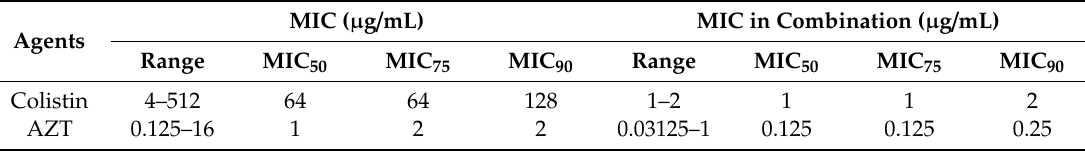
Figure 1. Distribution of the examined resistance mechanisms among the 40 isolates. ( a ) non-KPC producers; #, number of simultaneous resistance mechanisms (number of isolates) ( b ) KPC producers, with one isolate lacking data for outer membrane proteins.